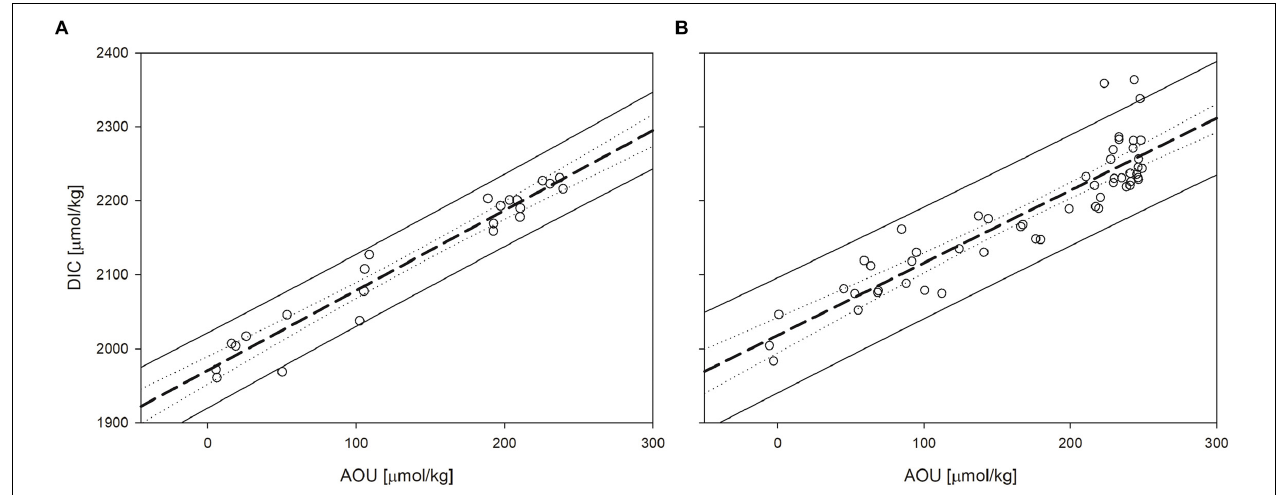
FIGURE 11 | Comparison between apparent oxygen utilization (AOU) and dissolved inorganic carbon (DIC) along the oxycline. See text for references. (A) June 2015 and (B) March 2016.